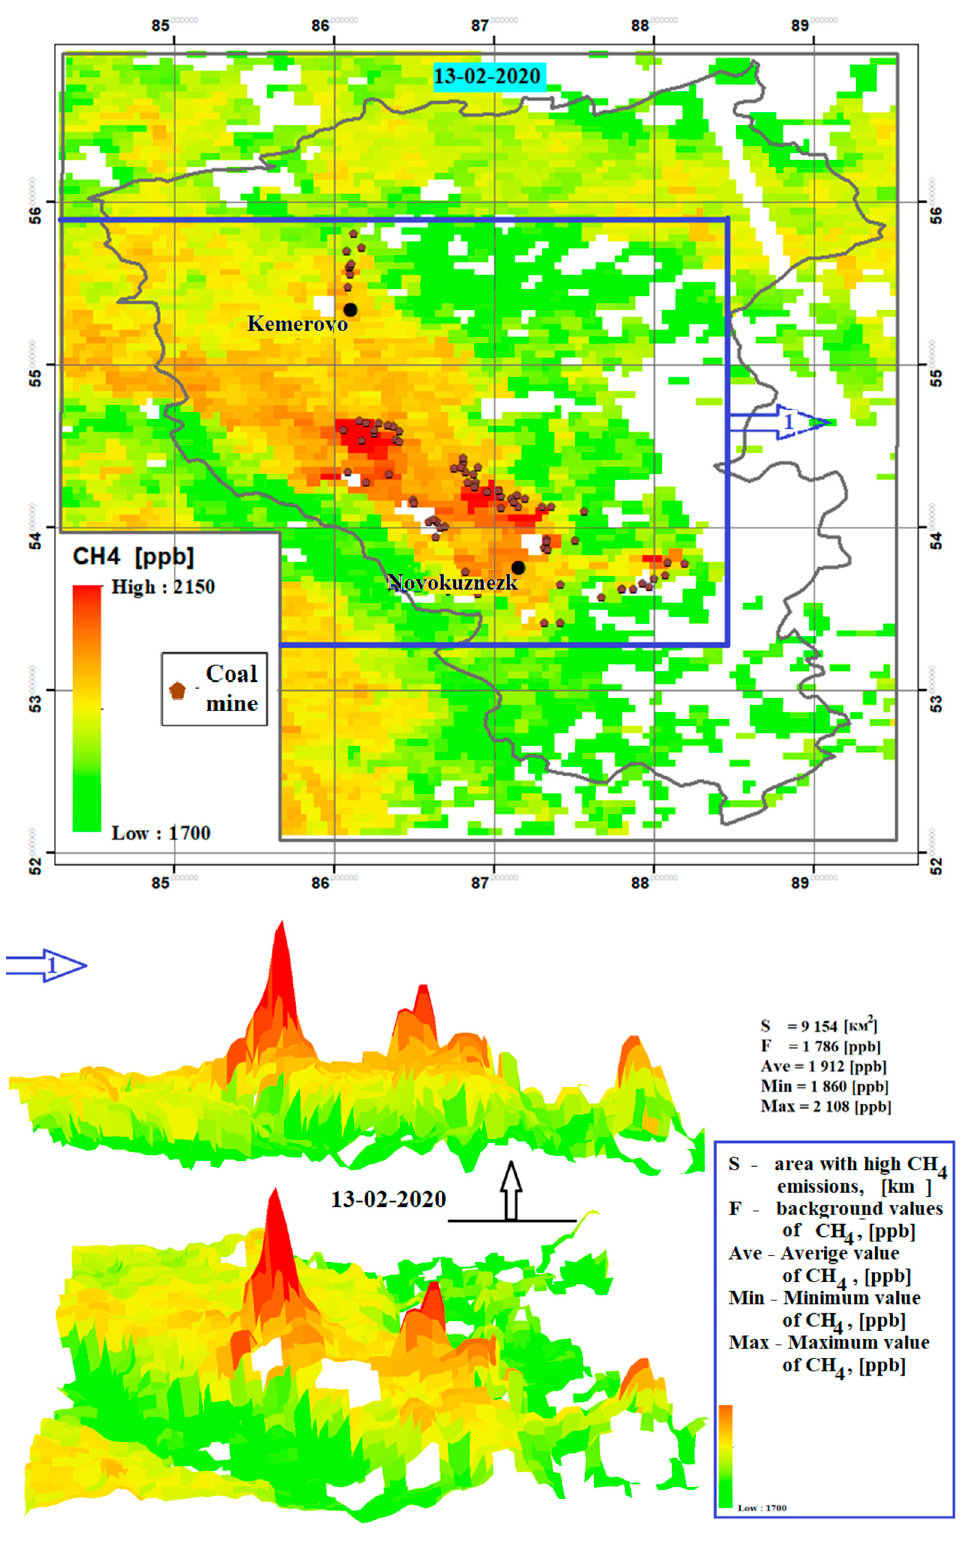
Figure 10. High methane emissions, registered on 13 February 2020. The blue rectangle ( top , 2D view) outlines the area shown in the 3D views ( bottom ). Data used—Sentinel-5P.